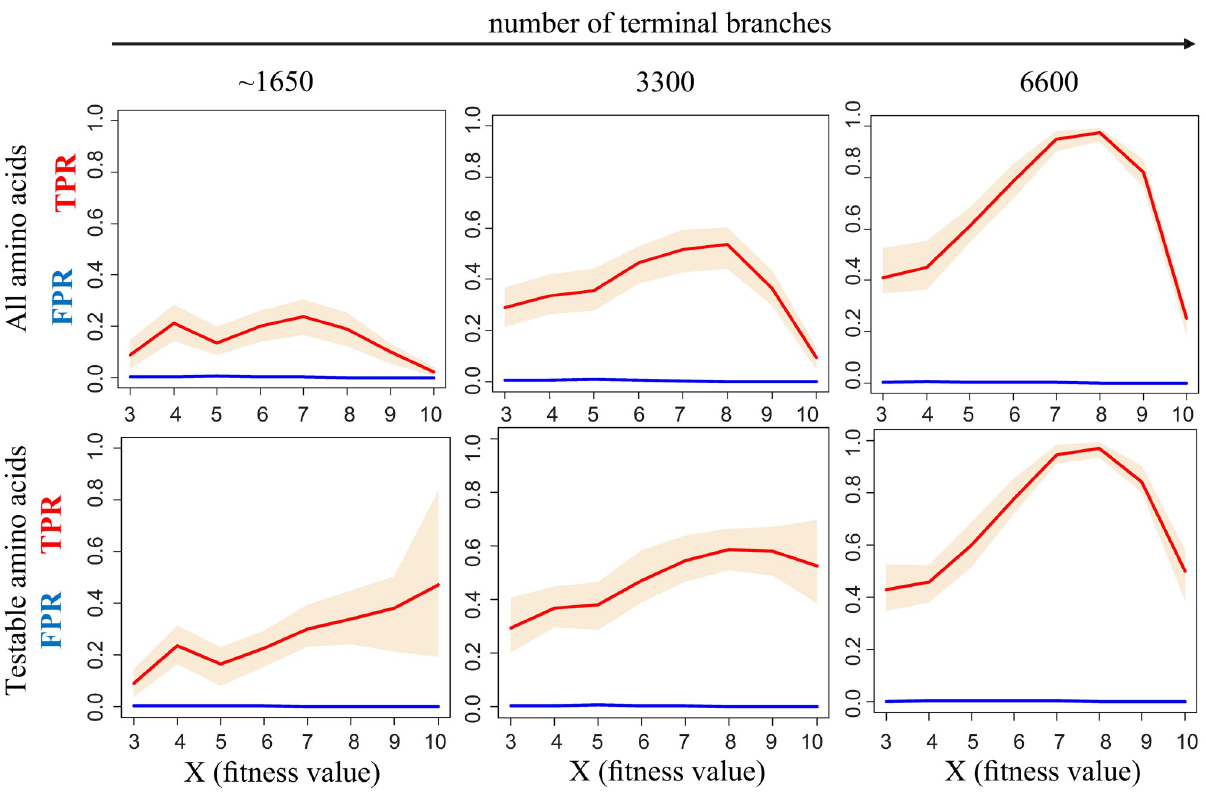
Fig 3. Performance of the d-test for “sparse” (~1650 tips), original (3300 tips) and “dense” (6600 tips) phylogenetic trees in simulations for different scaled fitness values of the preferred variant. Red line, median True Positive Rate (TPR); blue line, median False Positive Rate (FPR). 90% confidence bands were obtained by random subsampling of 1000 amino acids in 100 trials. Upper row: all amino acids are considered, bottom row– only testable amino acids are considered. A zoom-in for low FPR values is shown in Fig B in S1 File.